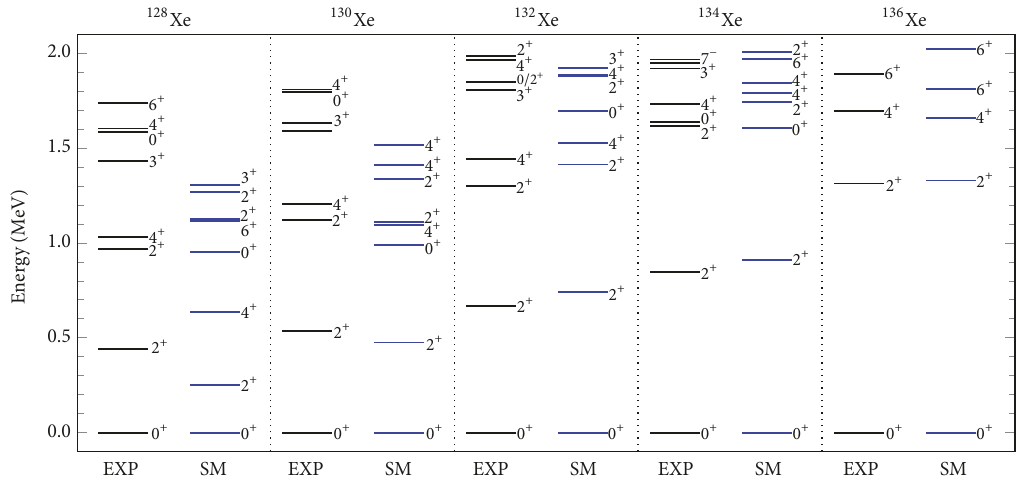
Figure 2: Experimental and shell-model energy spectra of even-mass xenon isotopes. A maximum of eight lowest energy levels are shown for each isotope. From left to right: 128 Xe, 130 Xe, 132 Xe, 134 Xe, and 136 Xe.